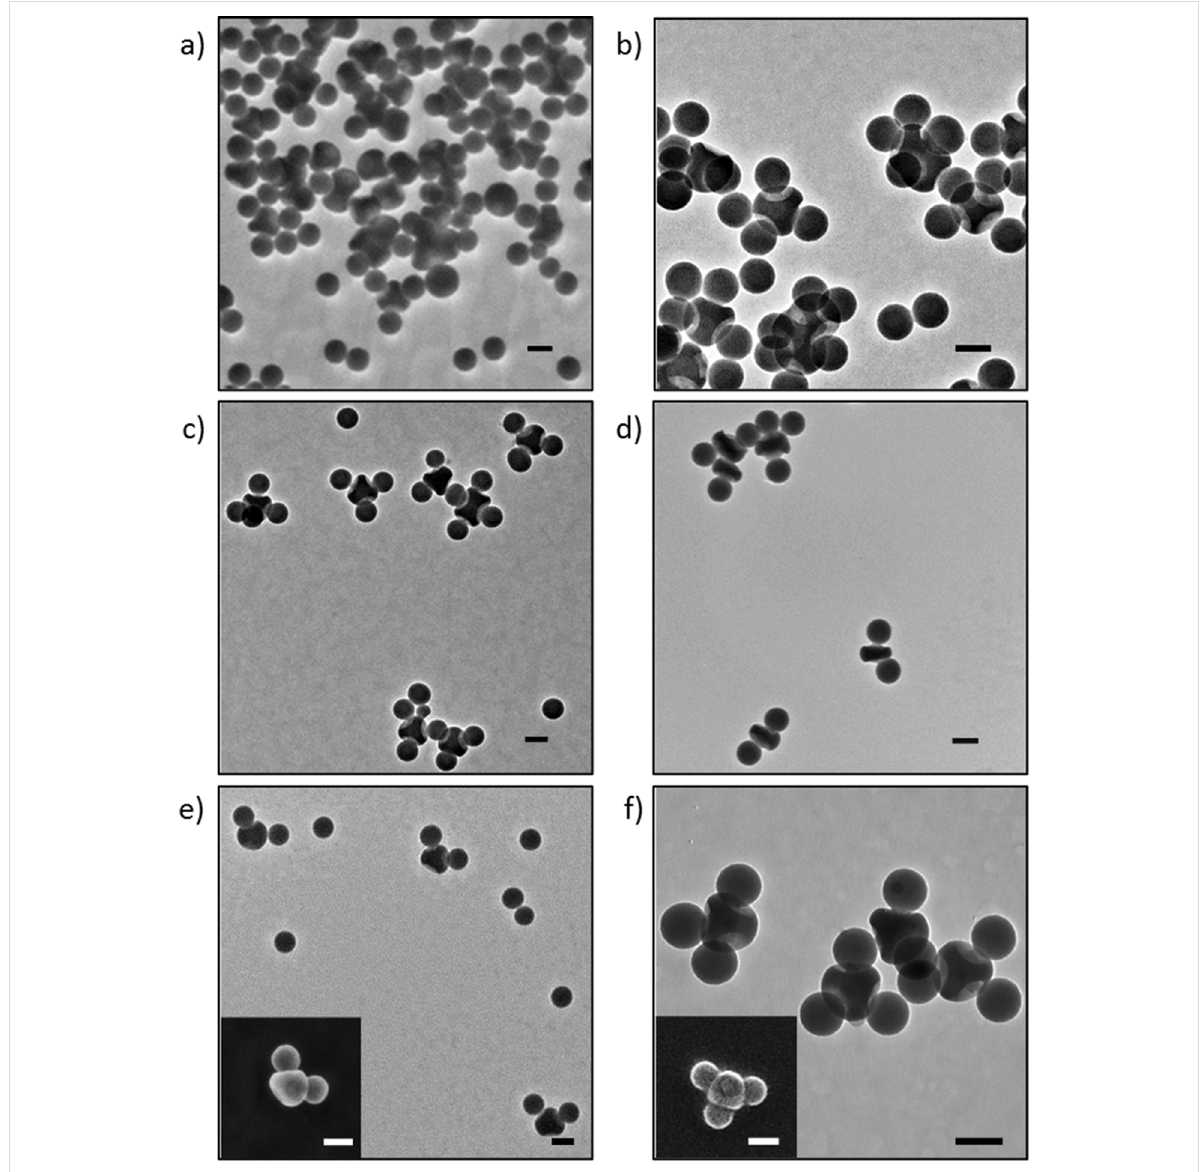
Figure 3: Top: TEM images of the CMs obtained from mixing particles with 4 aminated dimples with 100 nm silica nanospheres in a 1 /400 ratio before (a) and after (b) centrifugation. Middle: TEM images of the CMs obtained from mixing particles with 4 (c) and 2 (d) aminated dimples with 100 nm silica nanospheres in a 4 /4 and in a 2 /2 ratio, respectively. Bottom: TEM and SEM (inserts) images of the CMs obtained from mixing particles with 4 aminated dimples with 100 nm silica nanospheres in a 4 /2 (e) and in a 4 /3 (f) ratio. Scale bars: 100